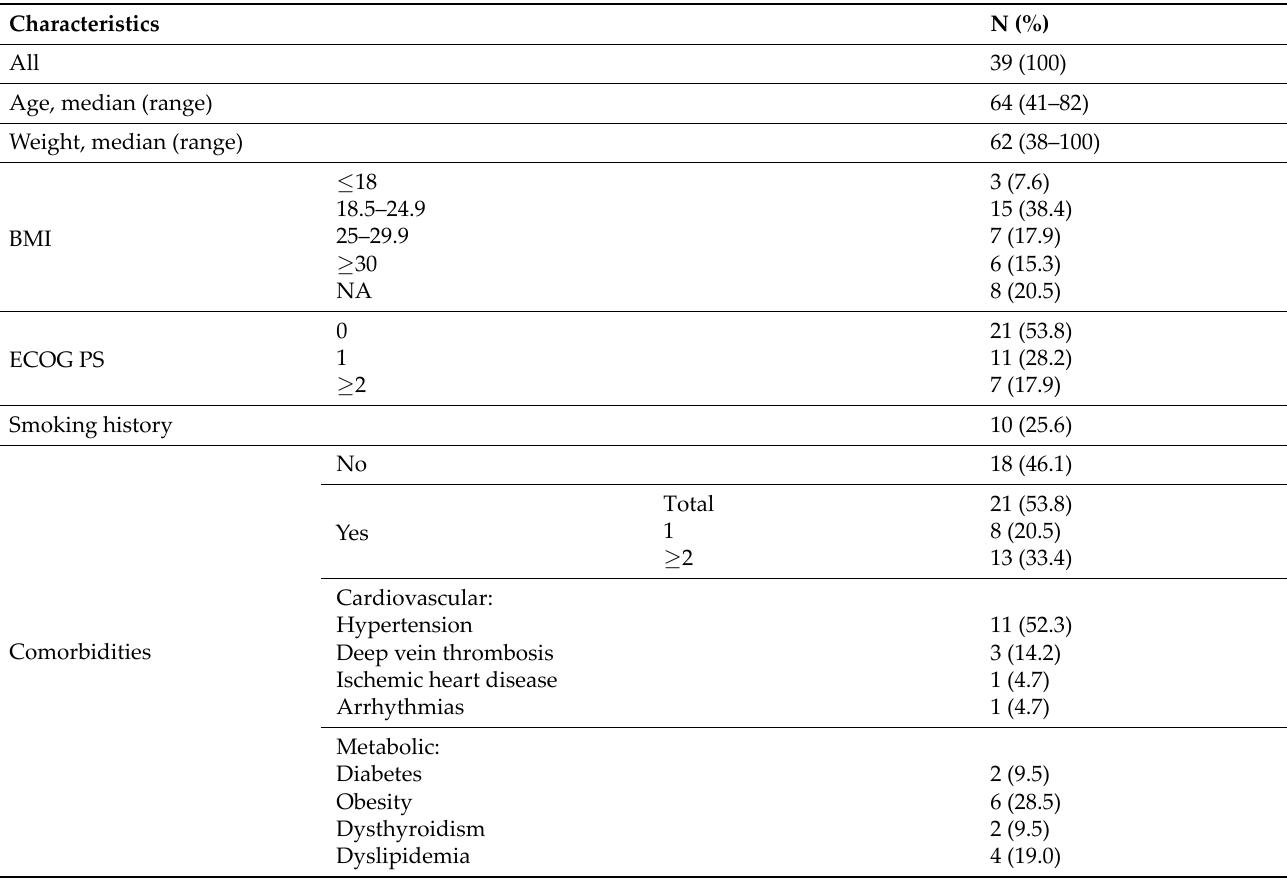
Figure 2. Consort diagram. Table 1. Baseline patients’ characteristics.